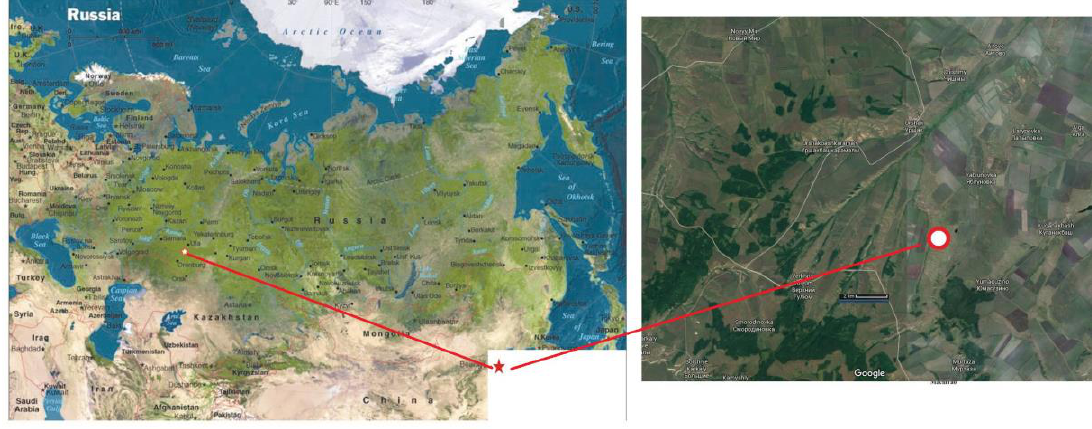
Figure 1. Study site location.